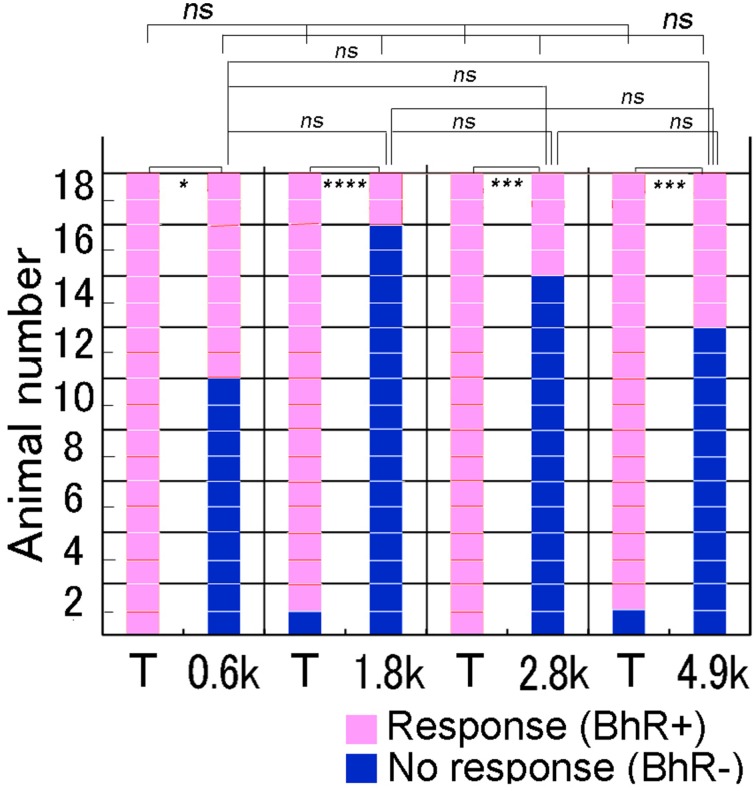
Performance of individual animals tested for discrimination of spectrally modified test sounds. In a test trial, one test sound is reproduced to animals together with the T sound (i.e., CS) as the positive control (see abscissa). Behavioral responses of each animal (on the ordinate) to the T and test sounds are shown along the horizontal line, while behavioral responses of all animals to each sound (on the abscissa) are shown in the vertical column. Animal's responses are considered to be positive (in pink) when they evoke unique behavioral reactions (BhRs, see text for details) that continue for a 3.2 s after the sound termination. When BhRs are not evoked or broken off, animal's behavior is considered to be negative (in dark blue). We suppose that animals initiate and continue the BhRs, because they have perceived the modified test sound to be the same as the CS, while animals discontinue the BhRs, because they have perceived the test sounds to be different from the T sound (i.e., CS). #p < 0.05; *p < 0.005; **p < 0.001; ***p < 0.0005, ****p < 0.0001, and ns: p > 0.05. The caption is also applicable to Figures 7,8.